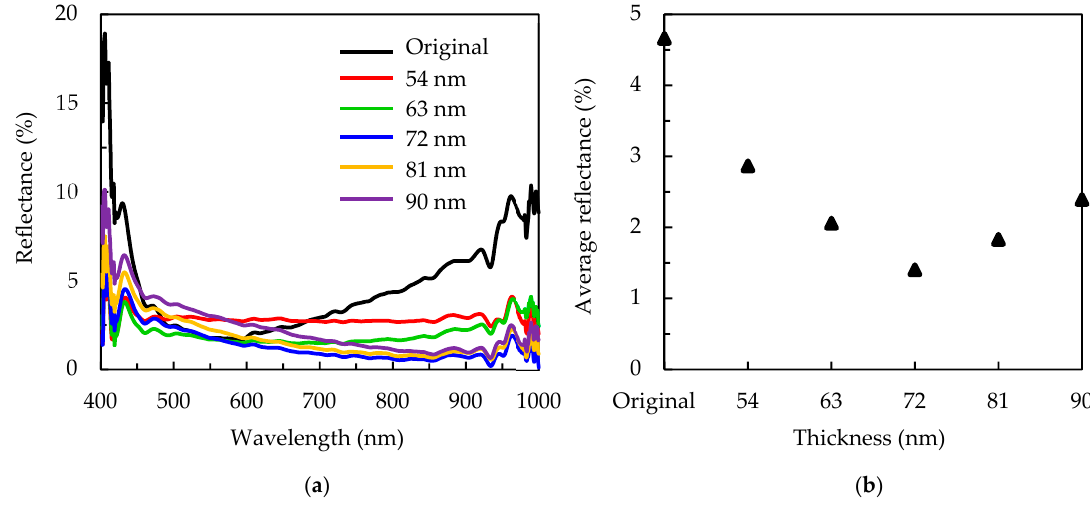
Figure 8. ( a ) Reflectance spectra, and ( b ) average reflectance for the 3 min MACE-treated silicon wafers covered with different SiN x thickness. The labeled “Original” refers to the pyramidal silicon wafer (without the MACE process) with the 90 nm SiN x /15 nm Al 2 O 3 stacked layer.